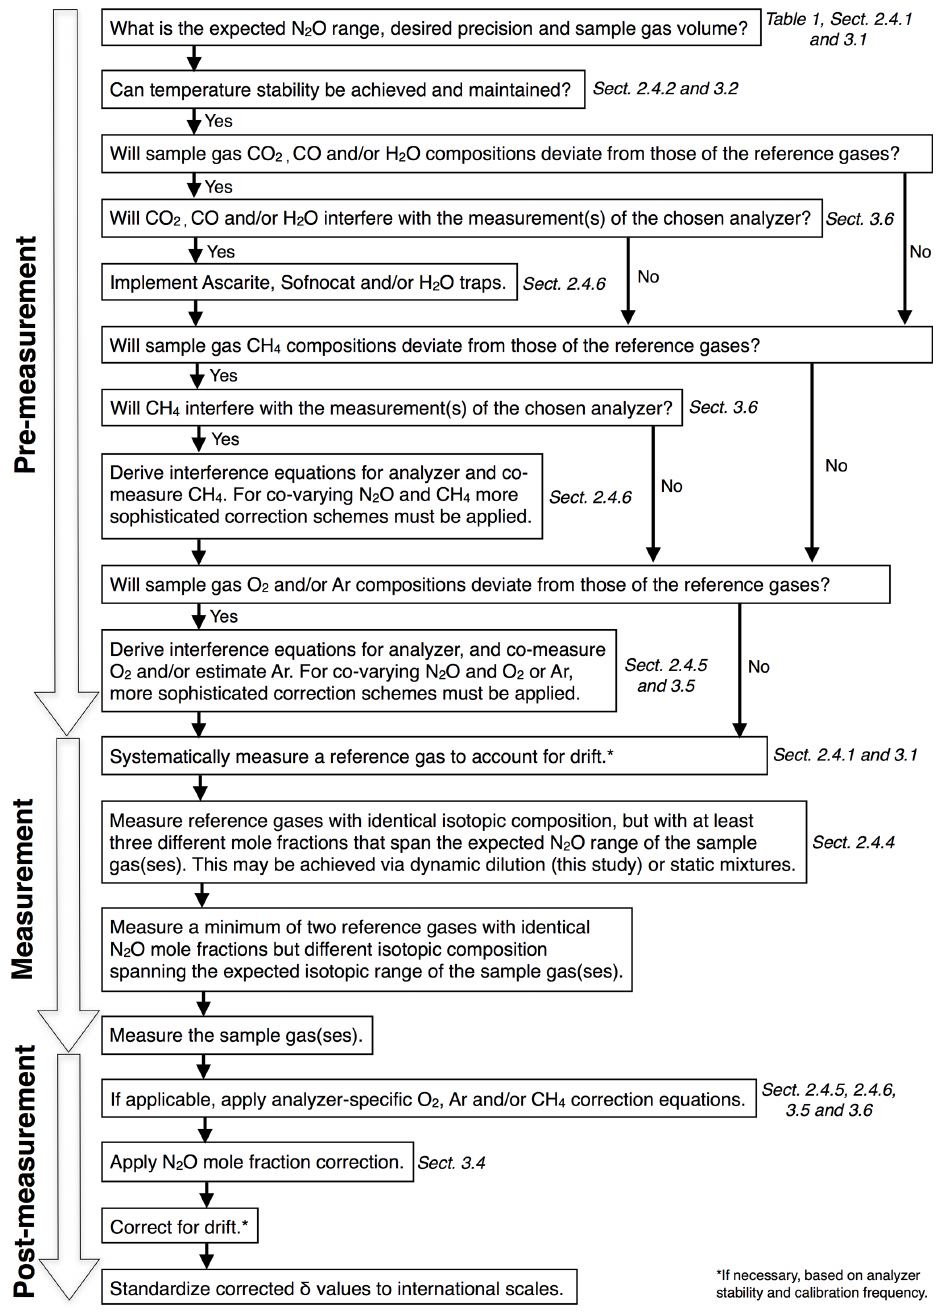
Figure 15. Proposed measurement workflow for the operation of N 2 O isotope laser spectrometers. Relevant sections of this study are shown next to each